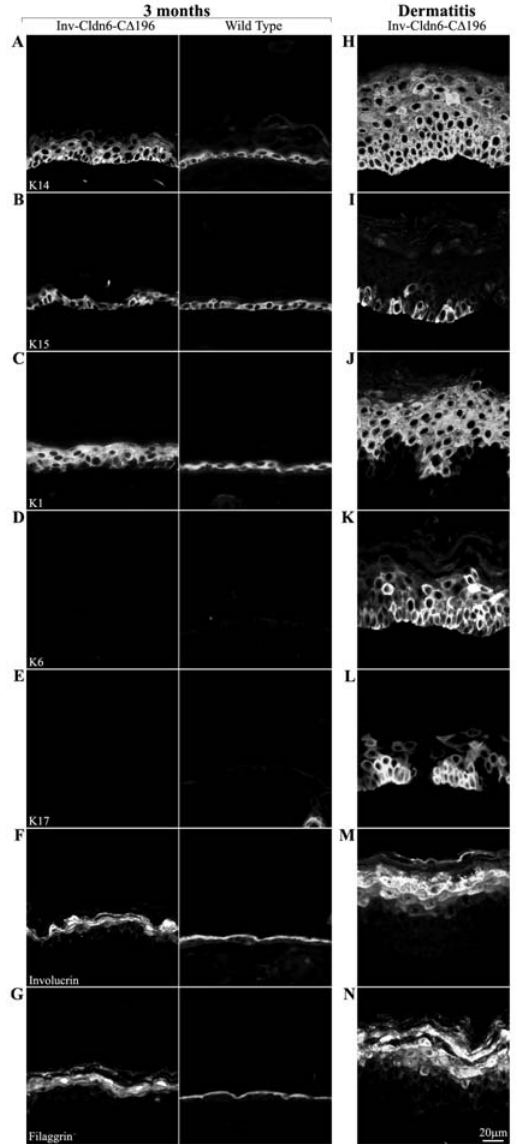
Figure 5. Aberrance in markers of epidermal differentiation during aging. Changes in the epidermal differentiation program of the aging Inv-Cldn6-C D 196 transgenic epidermis were evaluated by immunofluorescence and compared to their age-matched wild type counterparts (samples from 3-month-old mice are shown – left panel); their expression/localization in dermatitis-affected areas is also indicat- ed (right panel). K14 was expressed throughout the basal and suprabasal compartments in the aging Inv-Cldn6-C D 196 epidermis ( A ), while K15 remained restricted to basal cells ( B ). The zone of K1 expression was expanded in the 3-month-old transgenic epidermis ( C ); however, neither K6- ( D ) nor K17-positive ( E ) cells were observed. An expanded zone of expression, and improper packing, of involucrin ( F ) and filaggrin ( G ) suggested perturbations in terminal differentiation program of the aged Inv-Cldn6-C D 196 epidermis. In the dermatitis- affected areas, K14 ( H ) expression was expanded far into the suprabasal compartment, while K15 was only sporadically observed ( I ). A punctate K1 localization was evident throughout the thickened suprabasal zone of the dermatitis-affected Inv-Cldn6-C D 196 epidermis ( J ), and K6- ( K ) and K17-positive ( L ) basal and suprabasal cells were observed. In addition, involucrin ( M ) and filaggrin ( N ) expression compartments were also expanded, with obvious packing defects evident.